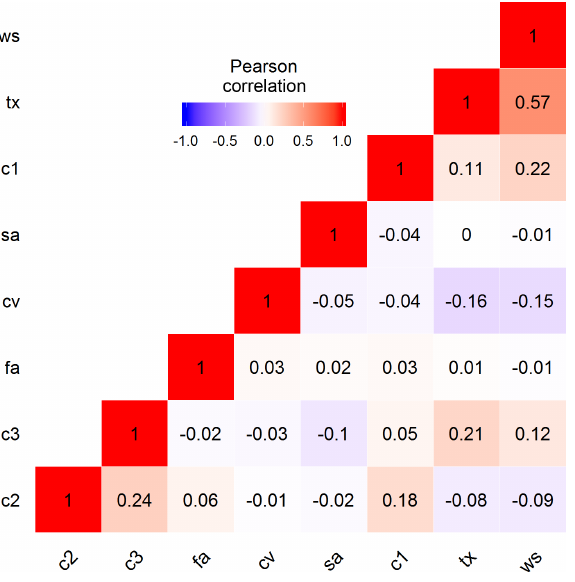
Figure 8. Pearson correlation matrix of the behavioural model pa- rameters identified using the coupled RF and limits of acceptability